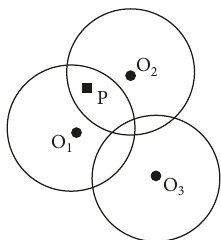
Figure 3: Sketch map of Cressman interpolation function. Square and circle points refer to CFD and WRF grid points,